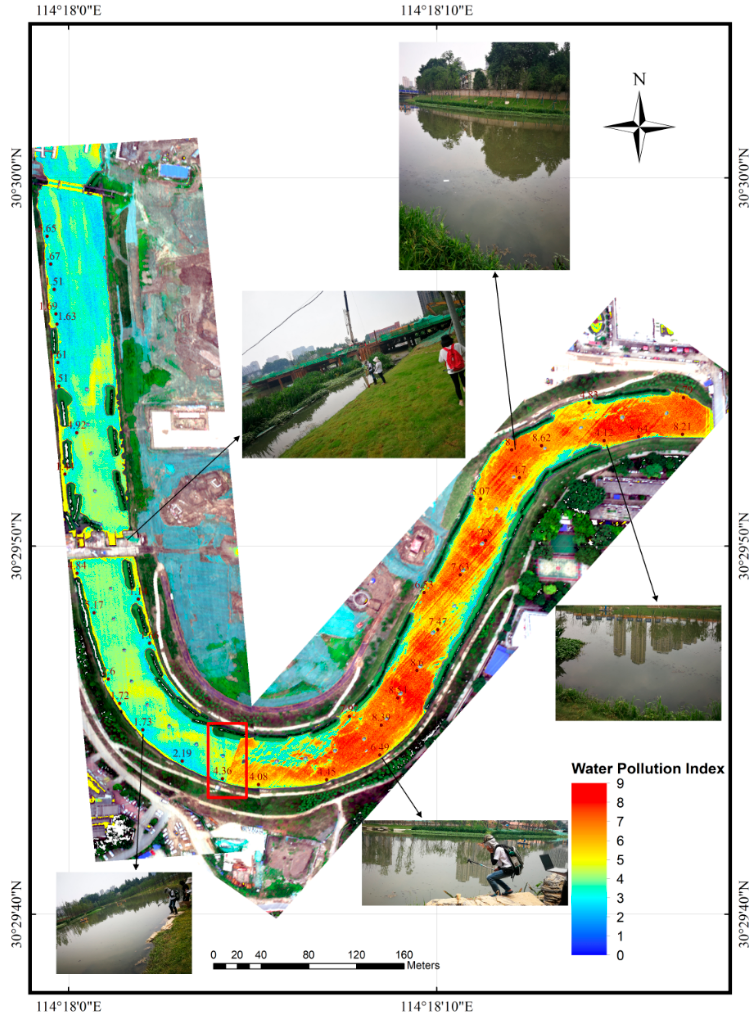
Figure 15. Inversion results for the Nemerow index based on GBDTR in the Xunsi River dataset.